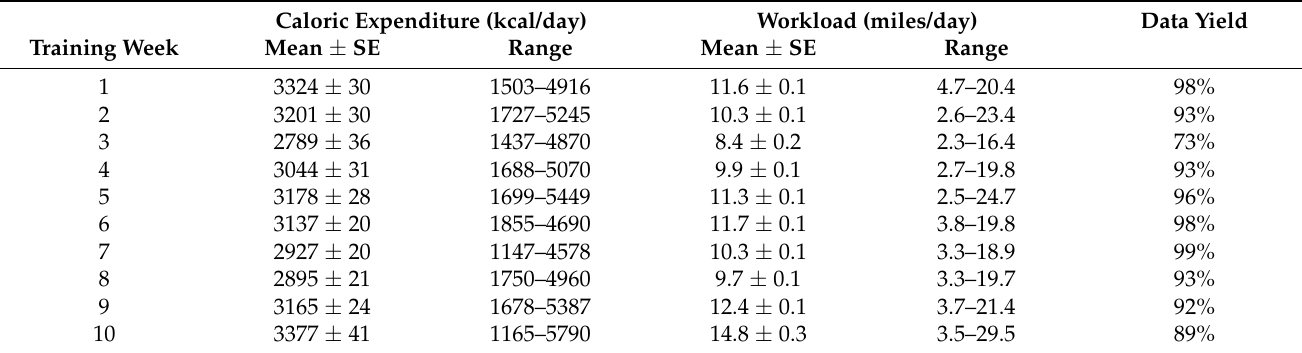
Table 4. Daily caloric expenditure and workload by training week.